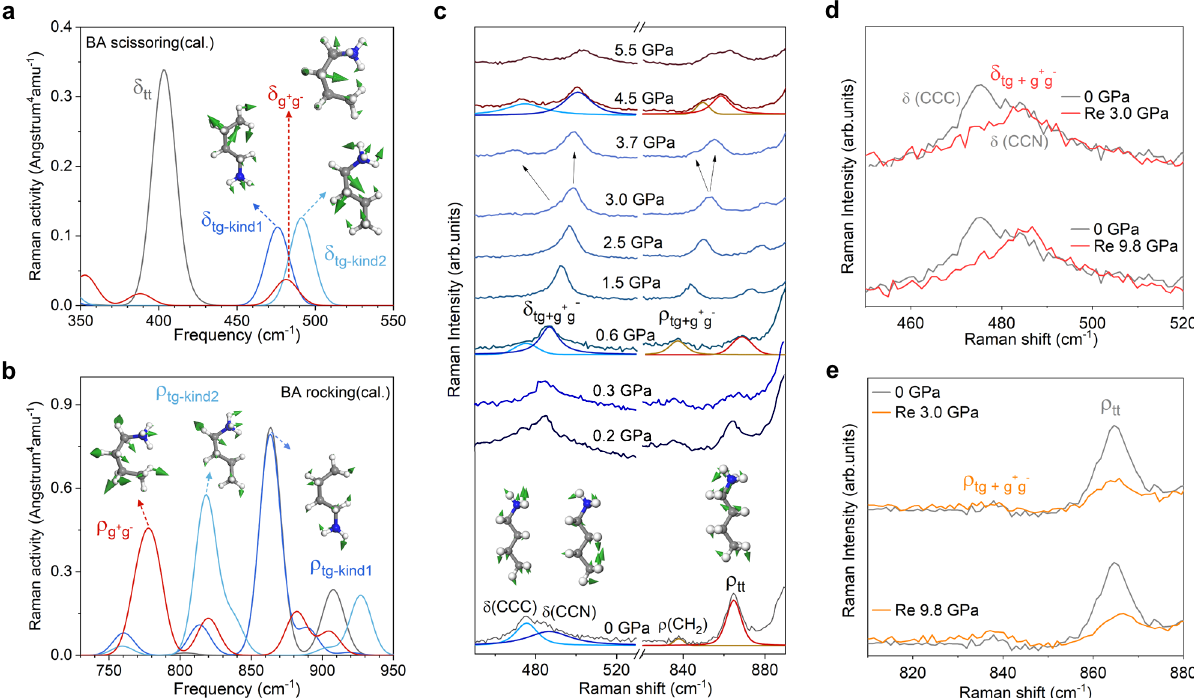
Fig. 4 | Raman characterization of the BA tg- and g + g - - conformers. a , b CalculatedRamanspectrafortheBAscissoringandrocking modesinthett,tg andg + g - structures. c TypicalRamanspectralevolutionof n =2RPPwithincreasing pressure. d , e Raman spectral comparison of RPP sample before and after com- pression. δ and ρ refers to scissoring and rocking vibrations. The grey, dark (light)